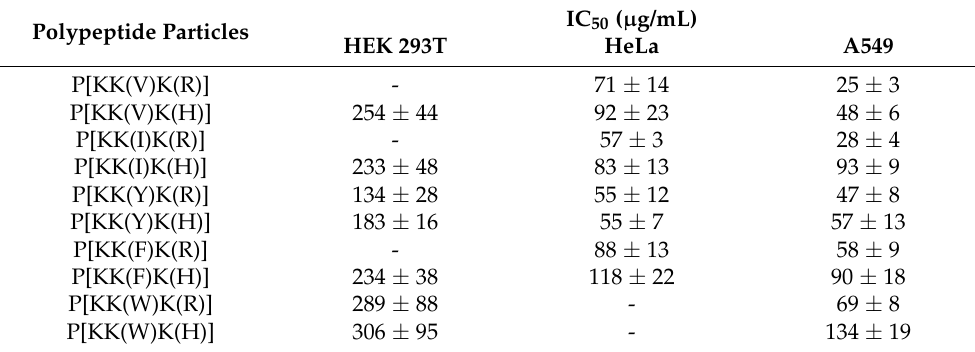
Table 4. Values of IC 50 determined for various polypeptide particles incubated with normal (HEK 293) and cancer (HeLa, A549) cells (MTT, 72 h).